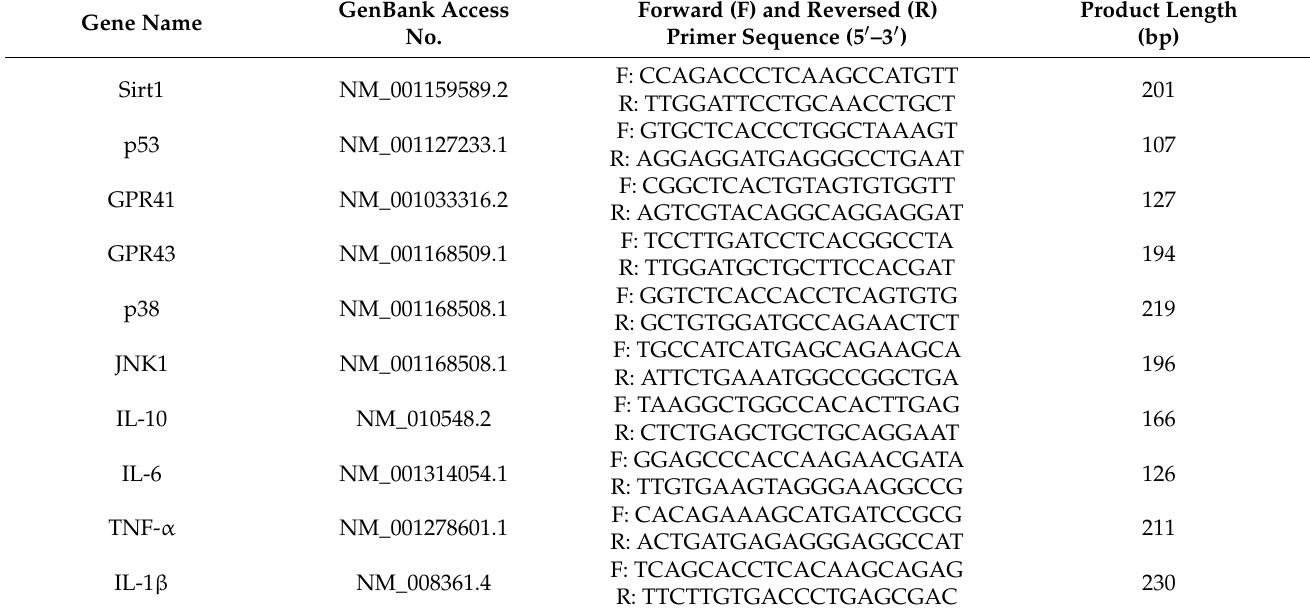
Table 2. Gene-specific primers used for real-time